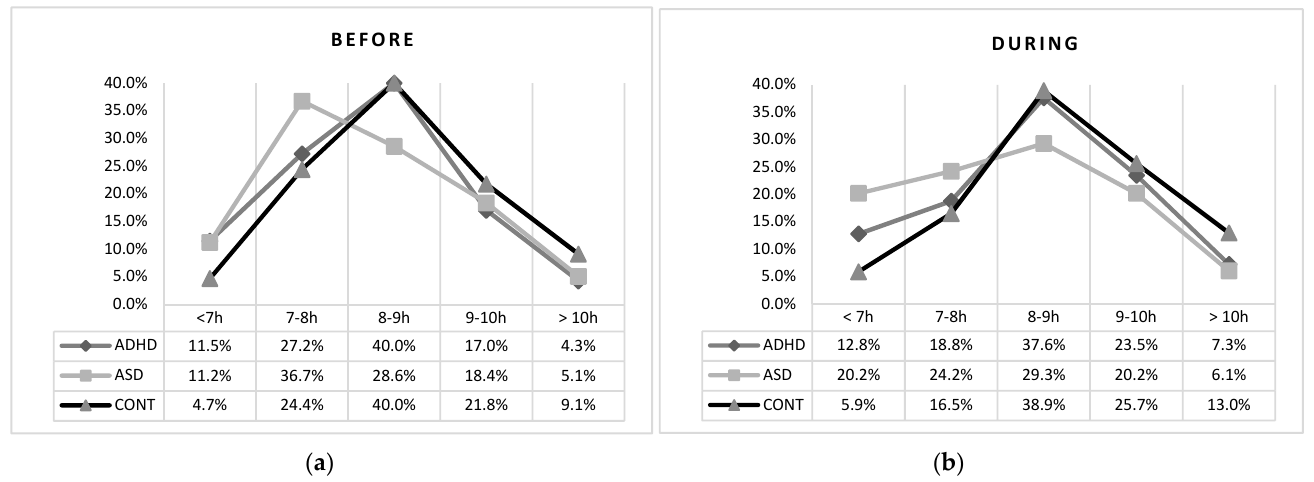
Figure 3. Sleep duration before ( a ) and during ( b ) lockdown in the tree groups. During lockdown, no differences in sleep duration were found between the two clinical groups while both clinical groups had a significantly higher percentage of children sleeping less than 7 h than controls (Table 4; Figure 3).